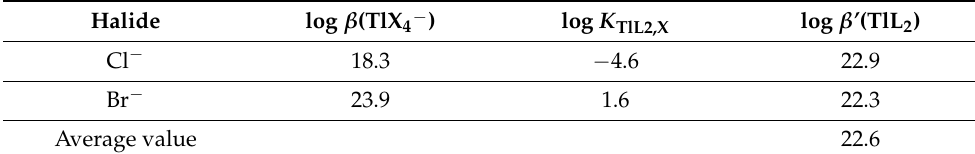
Similarly, the Equations (A9) and (A10) can be also used for calculation of (conditional) equilibrium constants of Tl(III)-PAR complexes